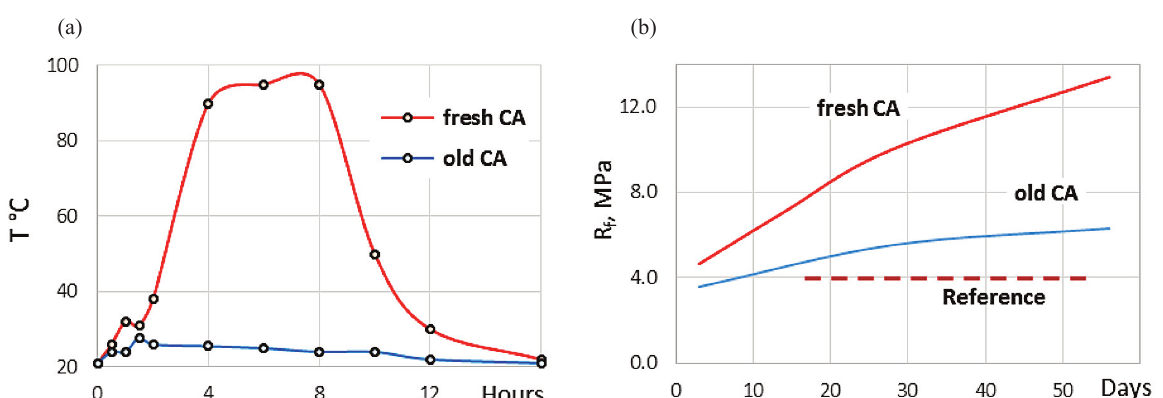
Fig. 5. Influence of mechanical activation on the behaviour and properties of CA: (a) self-heating at the hardening process; (b) increase in flexural strength Rf during